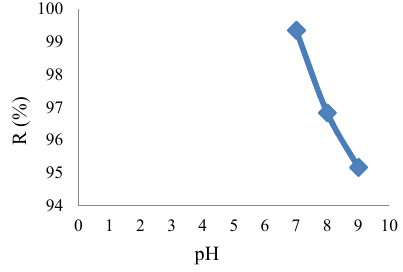
Fig. 3. Removal rate of Cu +2 at variable pH